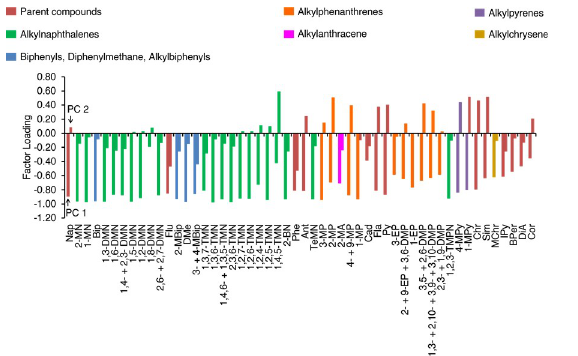
Fig 7. Factor loadings of PC1 and PC2 of PAH compounds.